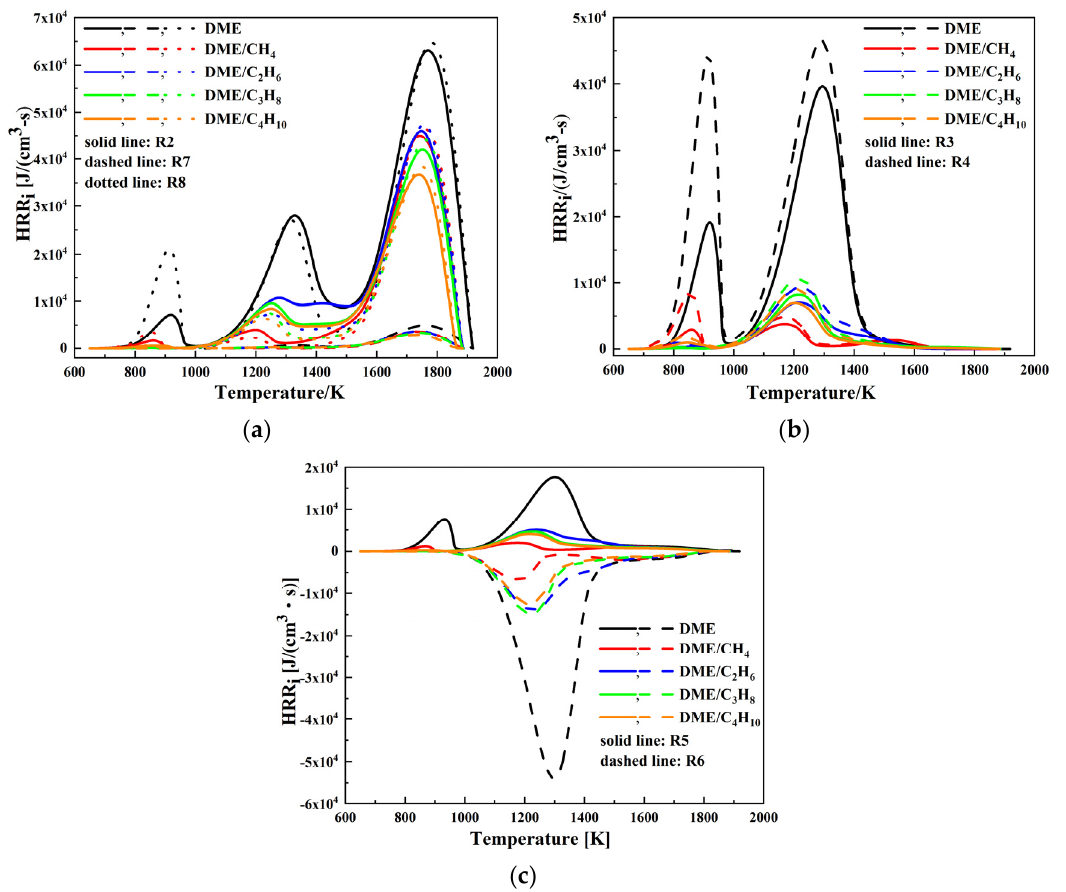
Figure 11. Comparison of pressure of DME/C1-C4 alkane mixtures for various equivalence ratios at T c = 650 K and P c = 20 bar: ( a ) φ = 0.3; ( b ) φ = 0.4; and ( c ) φ = 0.5.